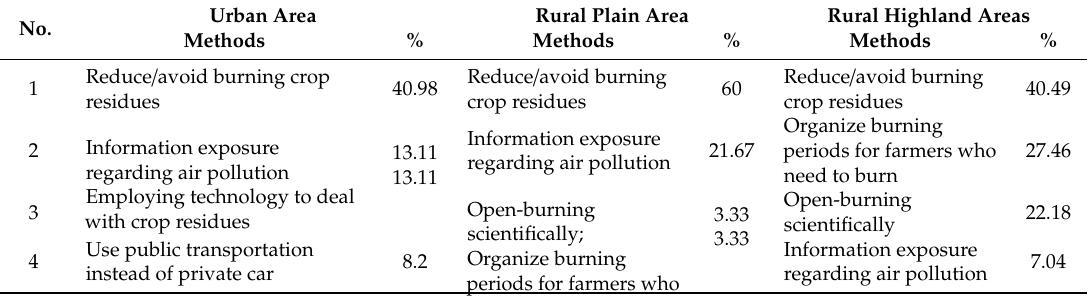
Table 6. Methods to cope with haze